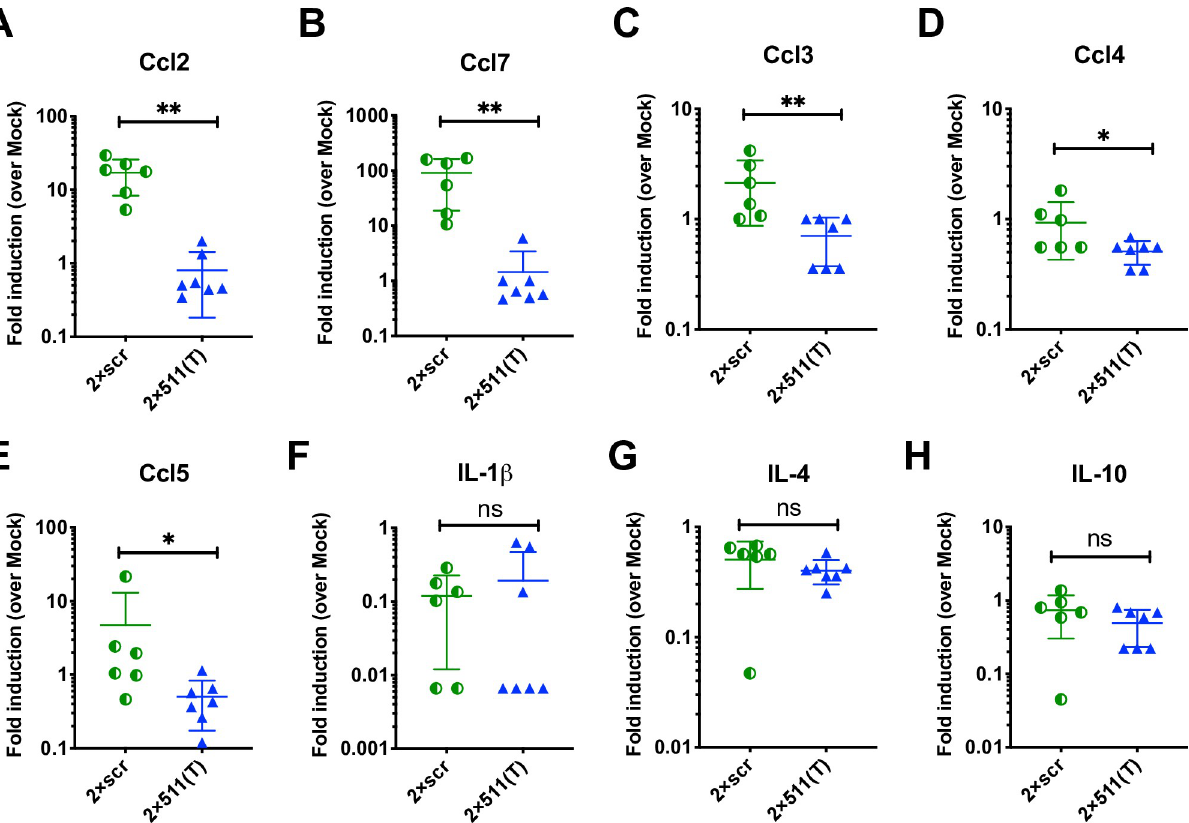
Fig 4. Infection of testicular macrophages is necessary for the production of macrophage-associated inflammatory mediators. Testis homogenates from AG129 mice infected with either 2 × scr (n = 6) or 2 × 511(T) (n = 7) or mock inoculated mice (n = 3) were collected at 3dpi and analyzed for chemokine and cytokine production by multiplexed ELISA. Fold induction over values found in mock-inoculated mice is shown as pg/g of tissue. ( A-E ) macrophage-associated chemokines and ( F-H ) representative markers of inflammation. Significance was determined by a two-tailed Mann-Whitney test. � indicates p < 0.05, �� indicates p <